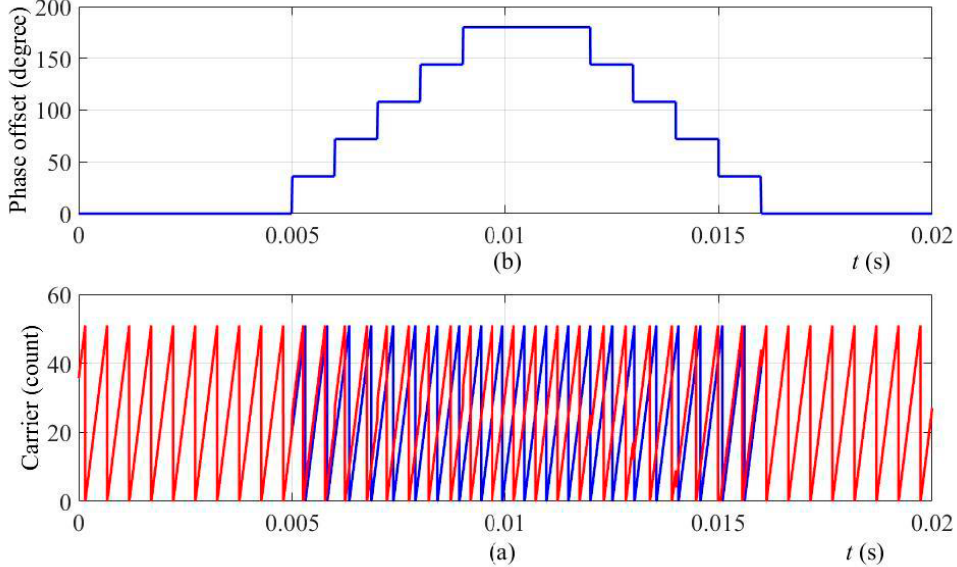
Figure 8. Carrier phase adjustment performance ( a ) carrier 2 offset; ( b ) the two carrier signals.